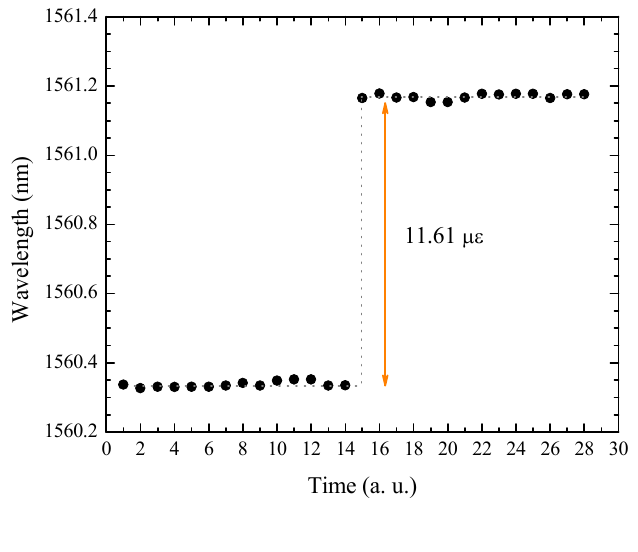
Figure 8. Laser strain sensor